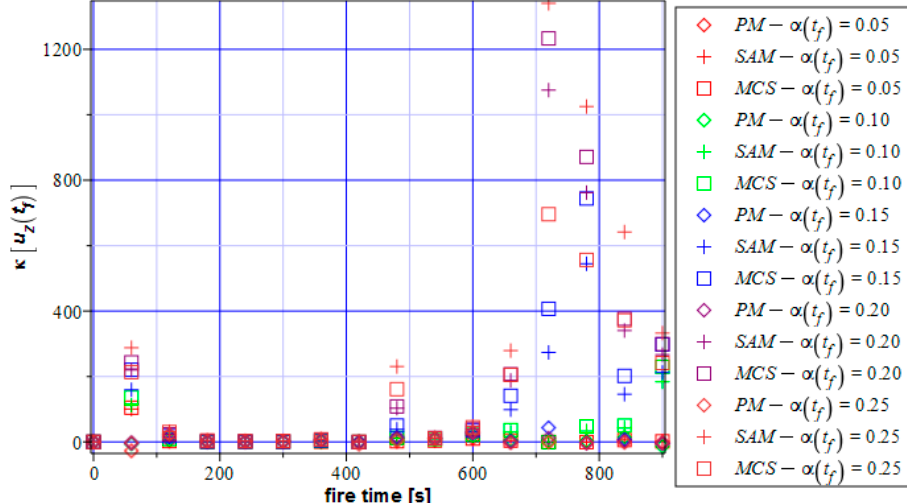
Figure 14. Kurtosis of the vertical deflections.